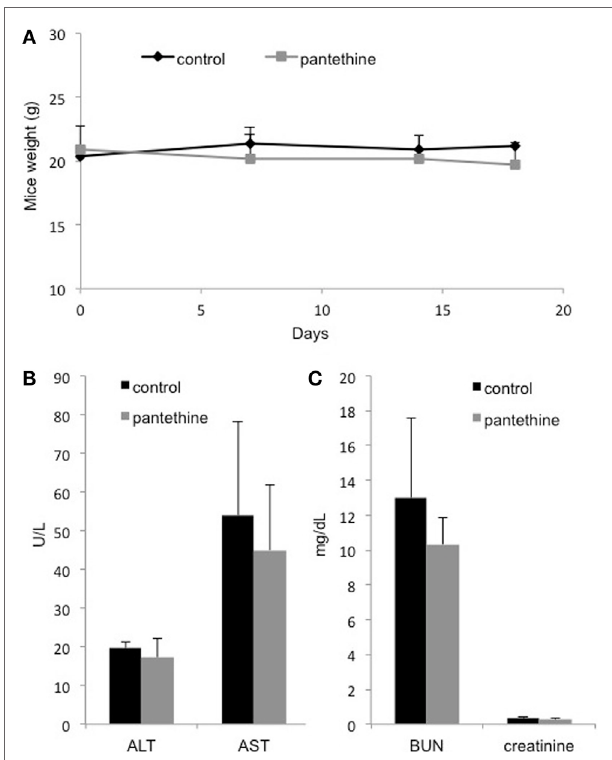
FigUre 7 | (a) Weight curves from control and treated mice. Serum levels of ALT, AST, (b) BUN, and creatinine (c) in treated and control mice. n = 5; mean ± SD are